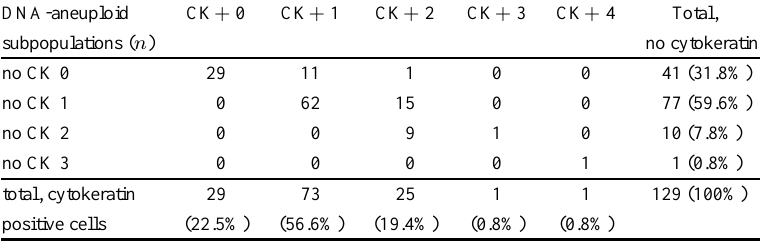
Ovarian cancer. Detection of DNA-aneuploid subpopulations dependent on gating of cytokeratin positive